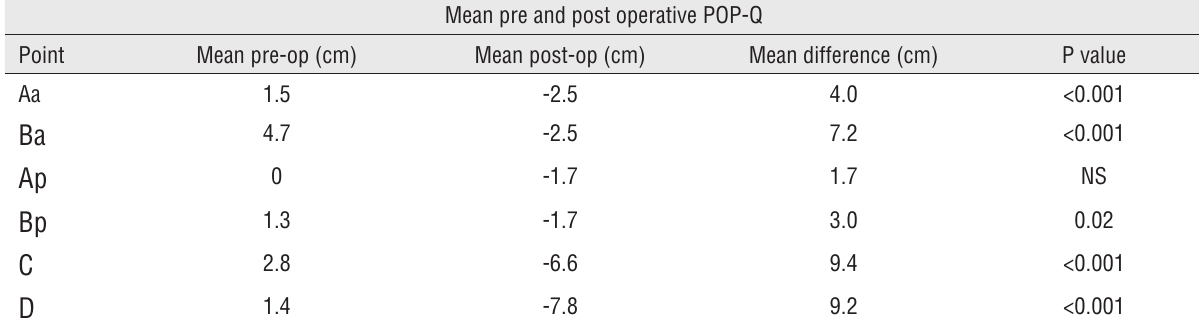
Table 3 - Pre and postoperative